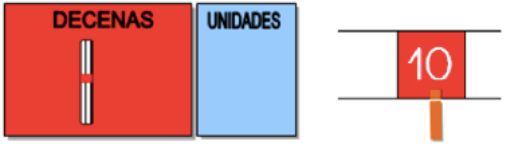
Figure 20. Number ten in box and number tape.